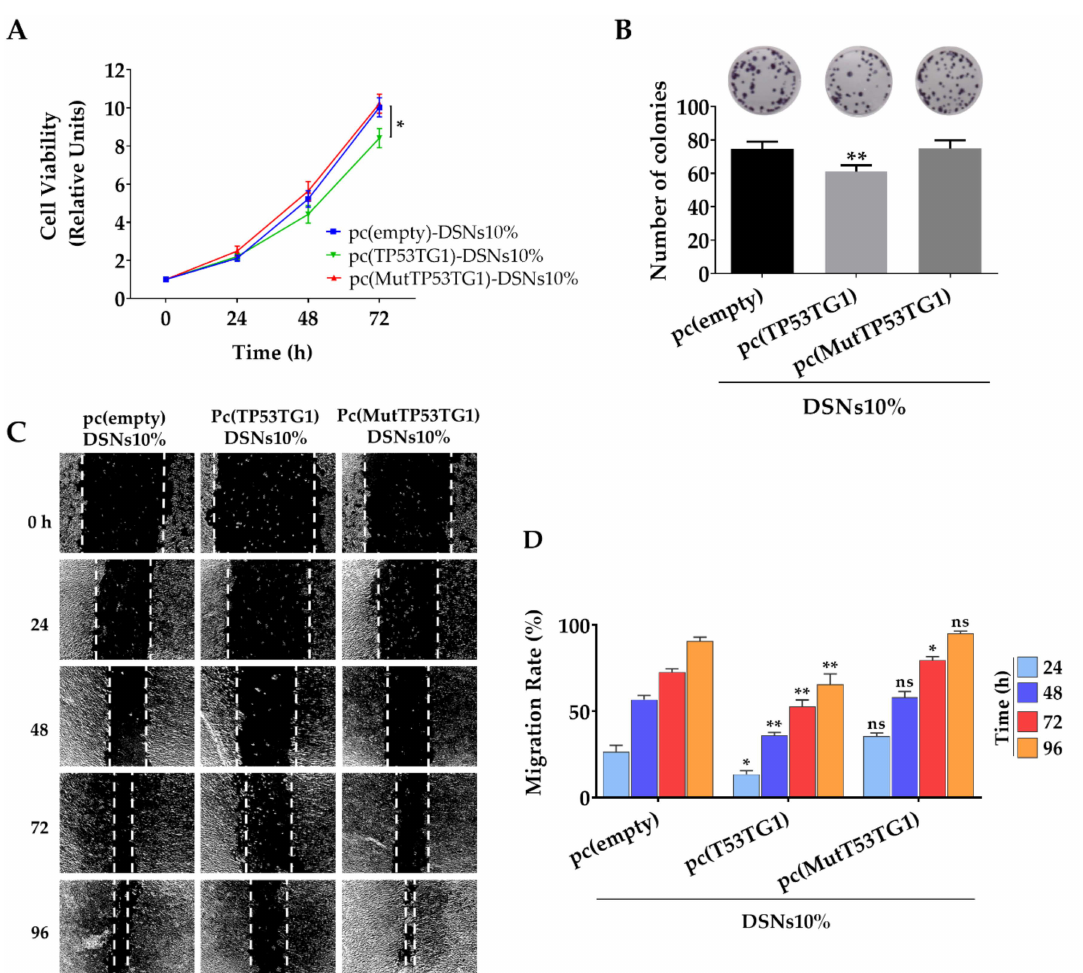
Figure 4. Tumor suppressor features of pc(empty)-DSNs10%, pc(TP53TG1)-DSNs10% and pc(MutTP53TG1)-DSNs10% in vitro. ( A ) HCT-116 cells’ viability determined each 24 h up to 72 h, after treatment with DSNs10%, associating different pcDNAs, for 4 h. Data is normalized to time point 0 h. ( B ) Effect of DSNs10%, associating different pcDNAs on the ability of HCT-116 cells to form colonies. HCT-116 cells were incubated with the nanosystems for 4 h and after 11 days the number of formed colonies was determined. ( C ) Wound healing assay was performed to evaluate the effect of the nanosystems on HCT-116 cell ability to migrate and close the wound. After creating a wound, the cells were treated with the nanosystems for 4 h ( n = 3). The evolution of the wound was monitored up to 96 h through direct observation under light microscope and photos were taken. ( D ) The migration rate (wound healing assay) was calculated using the acquired photos and data was normalized against time point 0 h. The effects of pc(TP53TG1)-DSNs10% and pc(MutTP53TG1)-DSNs10% were compared to the ones produced by pc(empty)-DSNs10% at each time point. (ns, not significant; * p < 0.05, ** p <